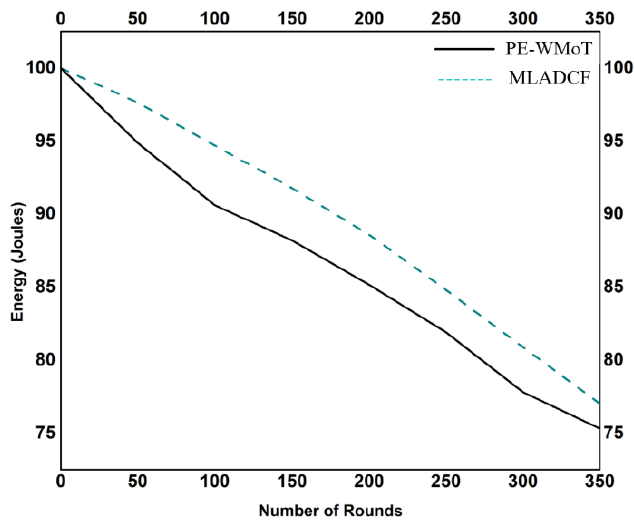
Figure 9. No. of Rounds Vs. Energy.